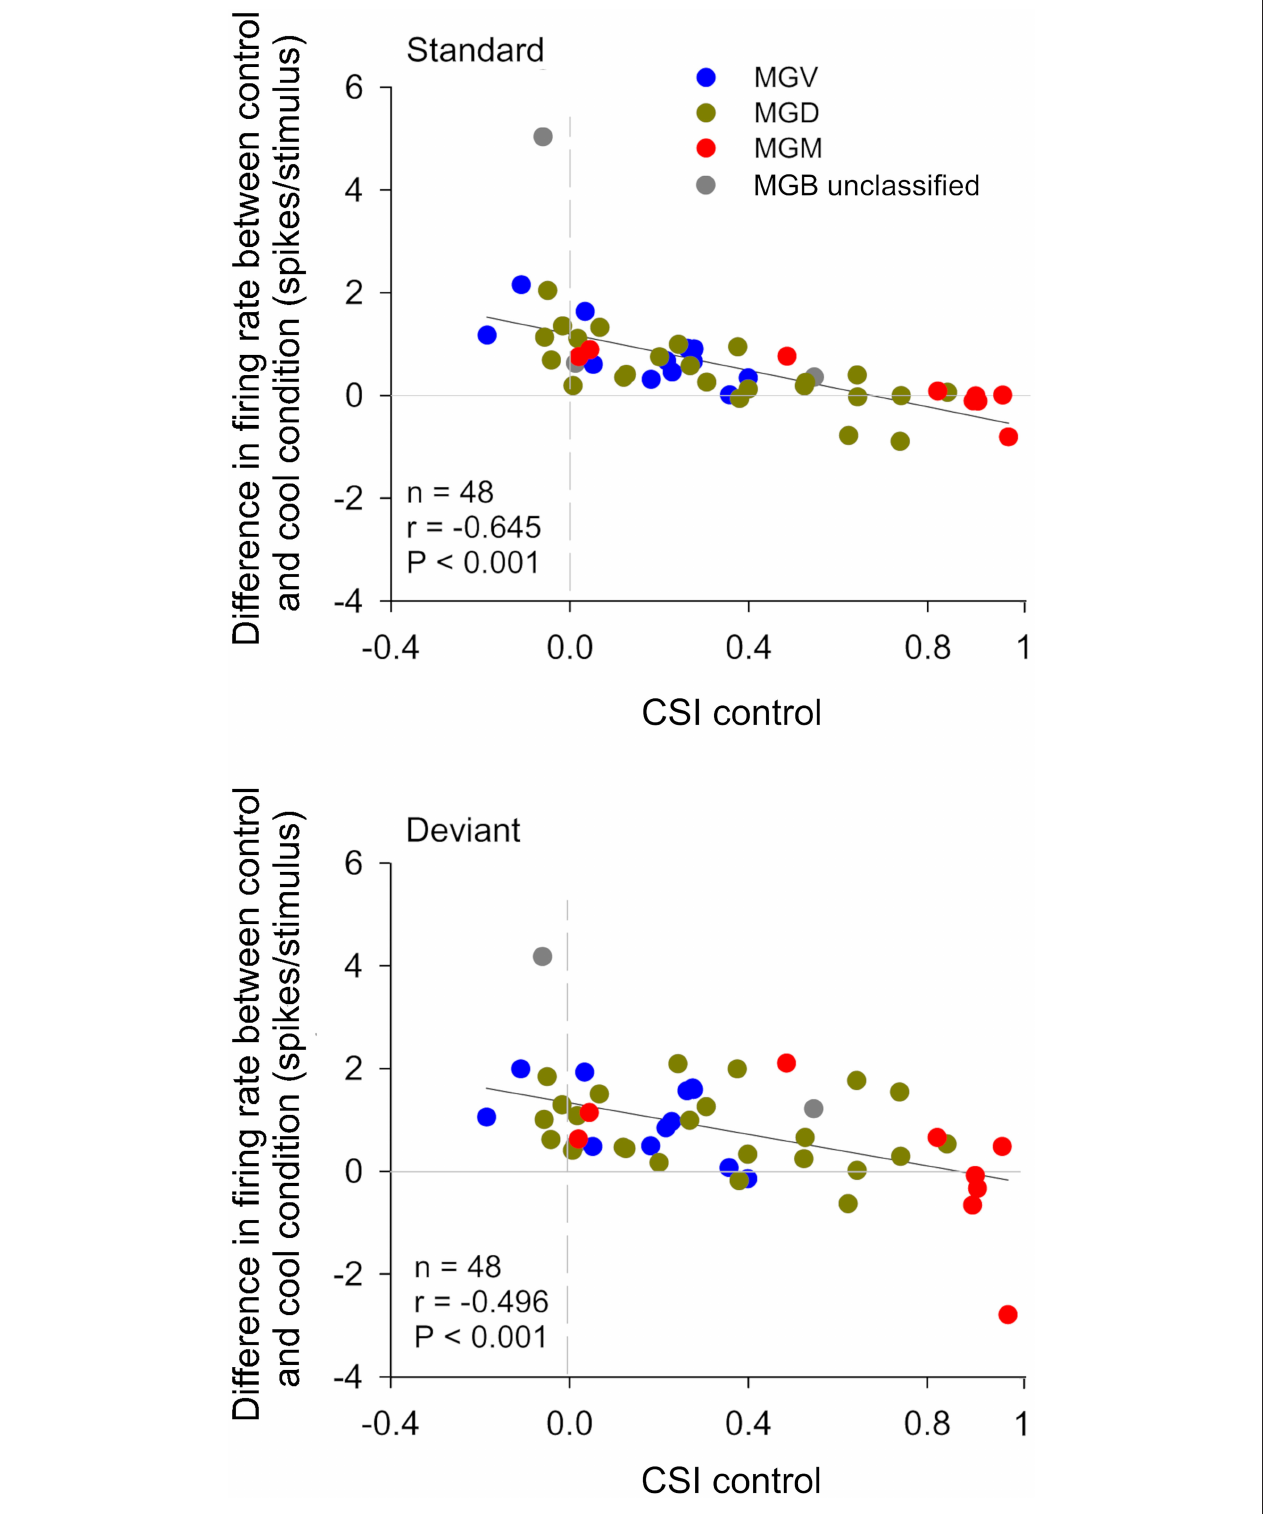
FIGURE 4 | The gain exerted by the cortex in auditory thalamic neurons depends on their ability to signal a deviance from previous stimulation context. Scatterplots of the CSI (control condition) vs. the difference in firing rate between the control and cool conditions (spikes/stimulus difference) in response to the standard (upper panel)